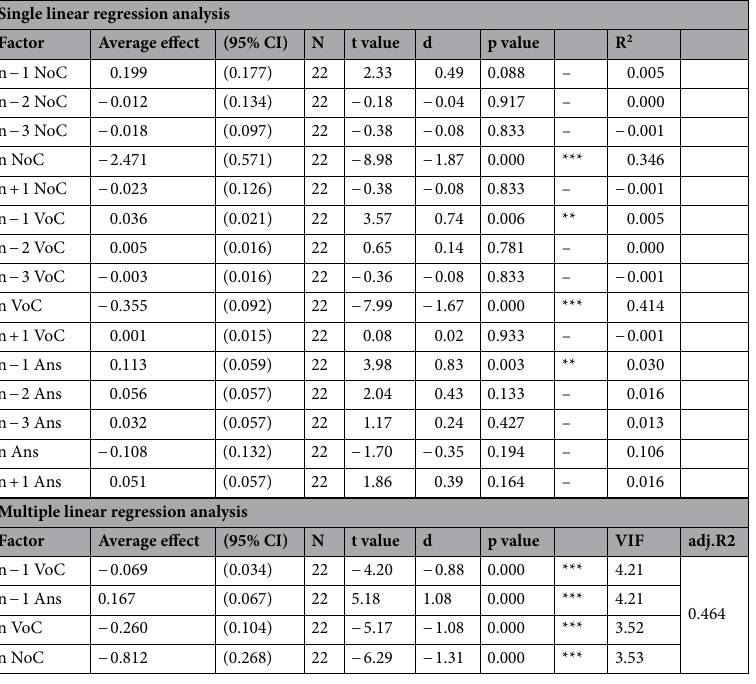
Table 2. Summary of the single and multiple regression analyses for Experiment 2. NoC indicates the number of coins, VoC indicates the monetary value of coins, and Ans indicates the participant’s